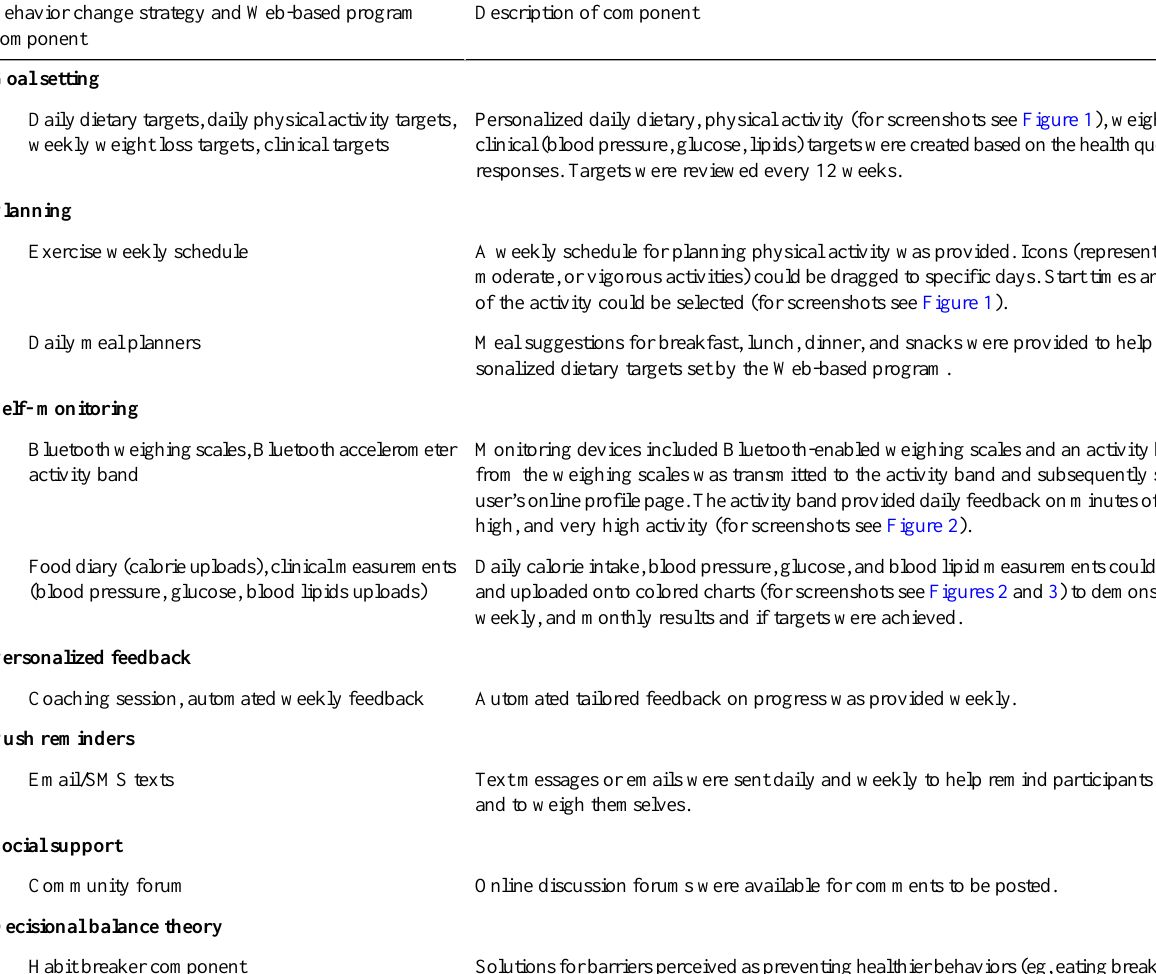
Table 1. Imperative Health Web-based program components to support behavior change.